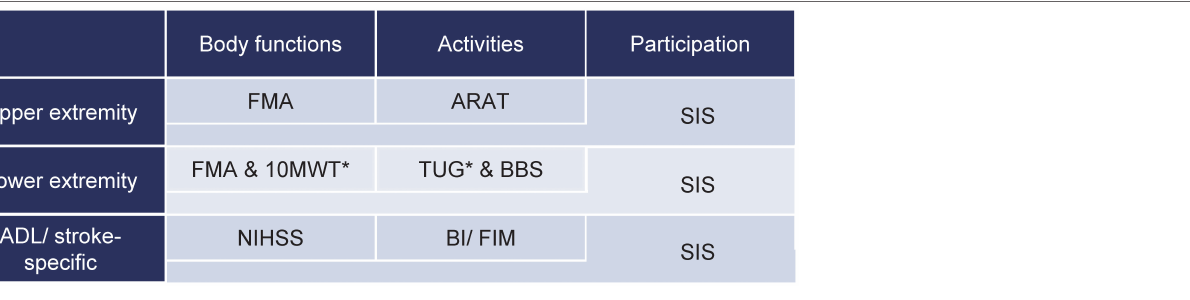
TABLE 2 | Core set of outcome measures for clinical motor rehabilitation after stroke.